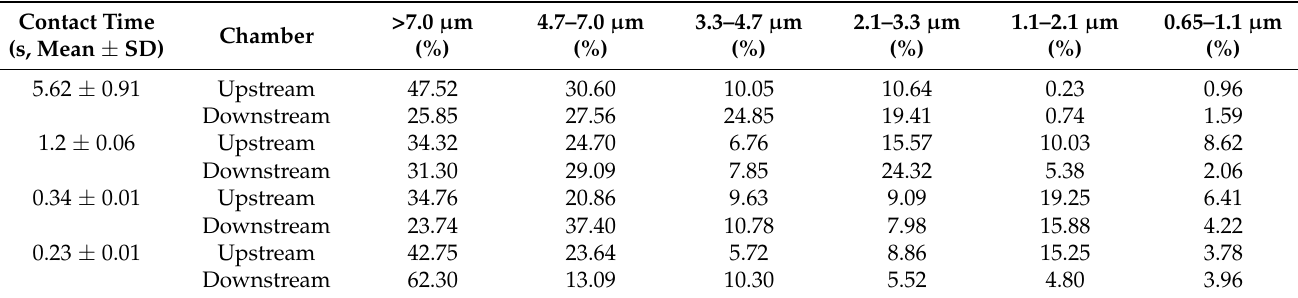
Table 1. Size distribution of airborne E. coli carried by poultry dust particles in upstream and downstream chambers.